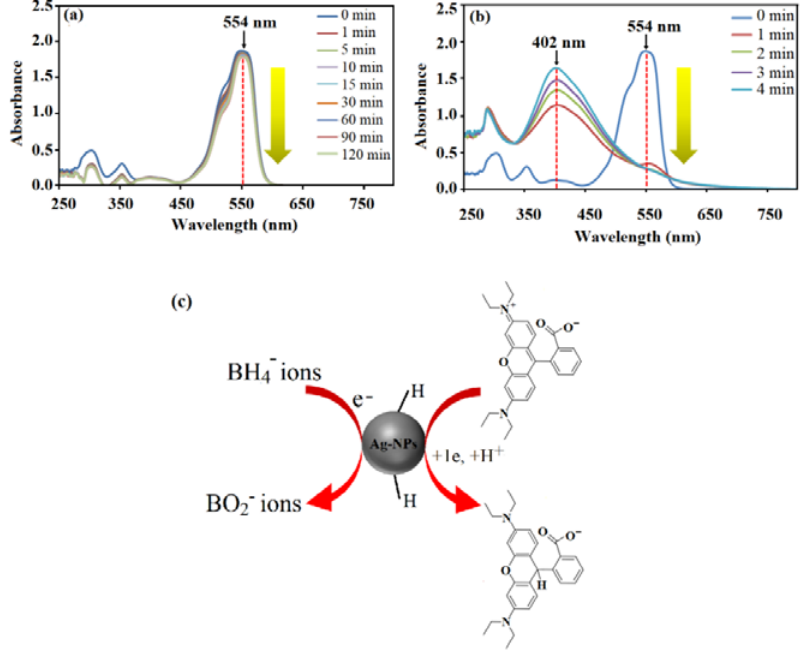
Figure 16. UV–vis spectra of reduction of RhB dye by ( a ) NaBH 4 alone, ( b ) in the presence of C. pentandra / Ag-NPs at 20 mg / L RhB and ( c ) the proposed mechanism of C. pentandra / Ag-NPs as nanocatalyst for the reduction of RhB dye.